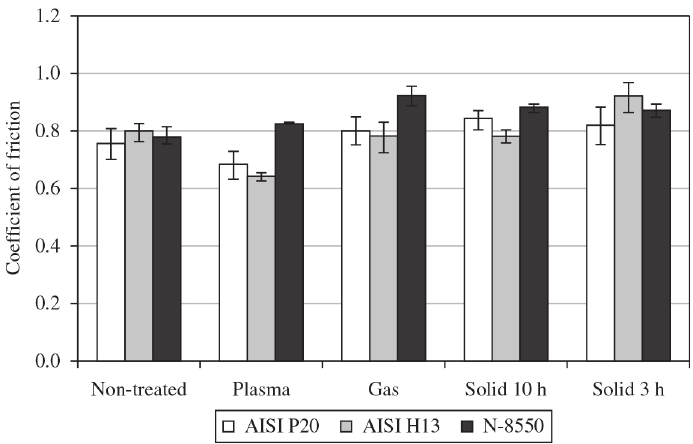
Figure 6. Coefficients of friction obtained during the wear